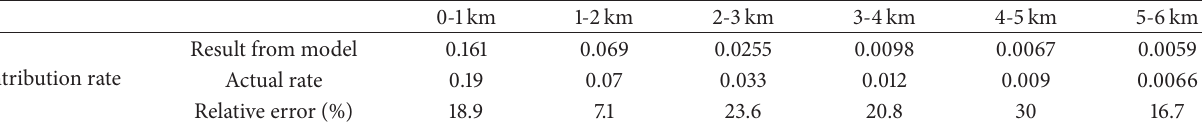
Table 7: Comparison of results from model and the real contribution rate.